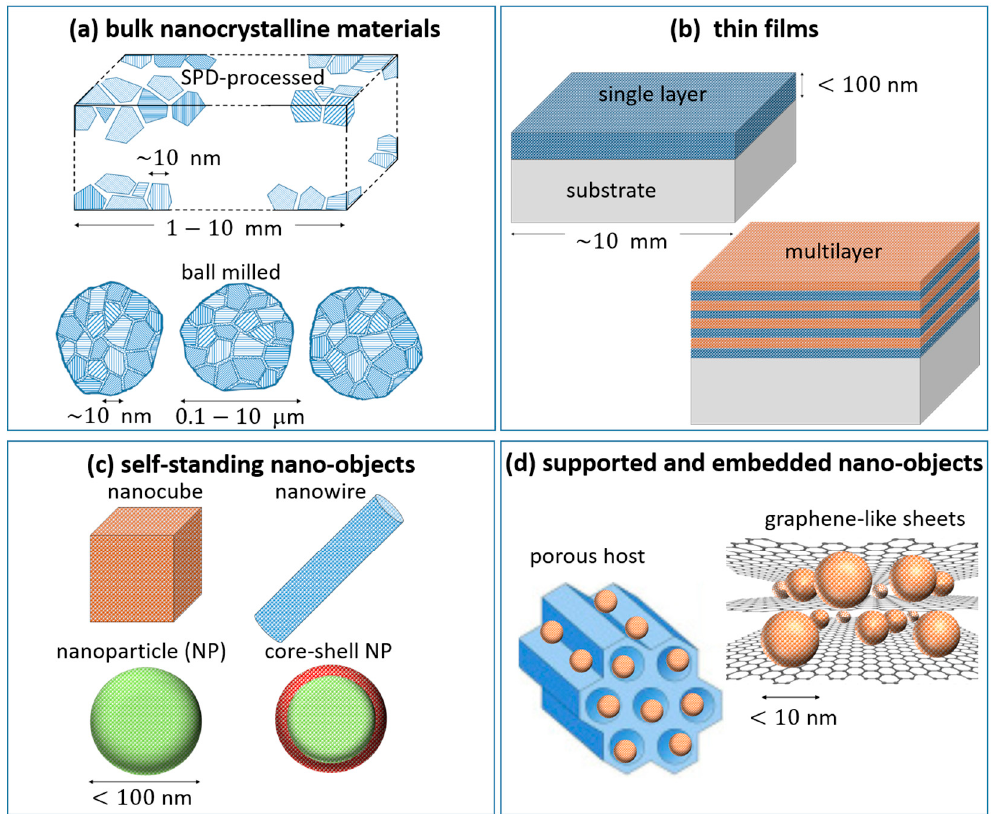
Figure 4. Main categories of nanomaterials for H storage discussed in this review (see text for details).  Bulk nanocrystalline materials (Figure 4a) have (cid:1838) (cid:3032)(cid:3051)(cid:3047) ≫ 100 nm in all directions and a fine microstructure (cid:1838) (cid:3040)(cid:3036)(cid:3030) ~10 nm. They are prepared by top-down mechanical deformation methods such as severe plastic deformation (SPD) and ball